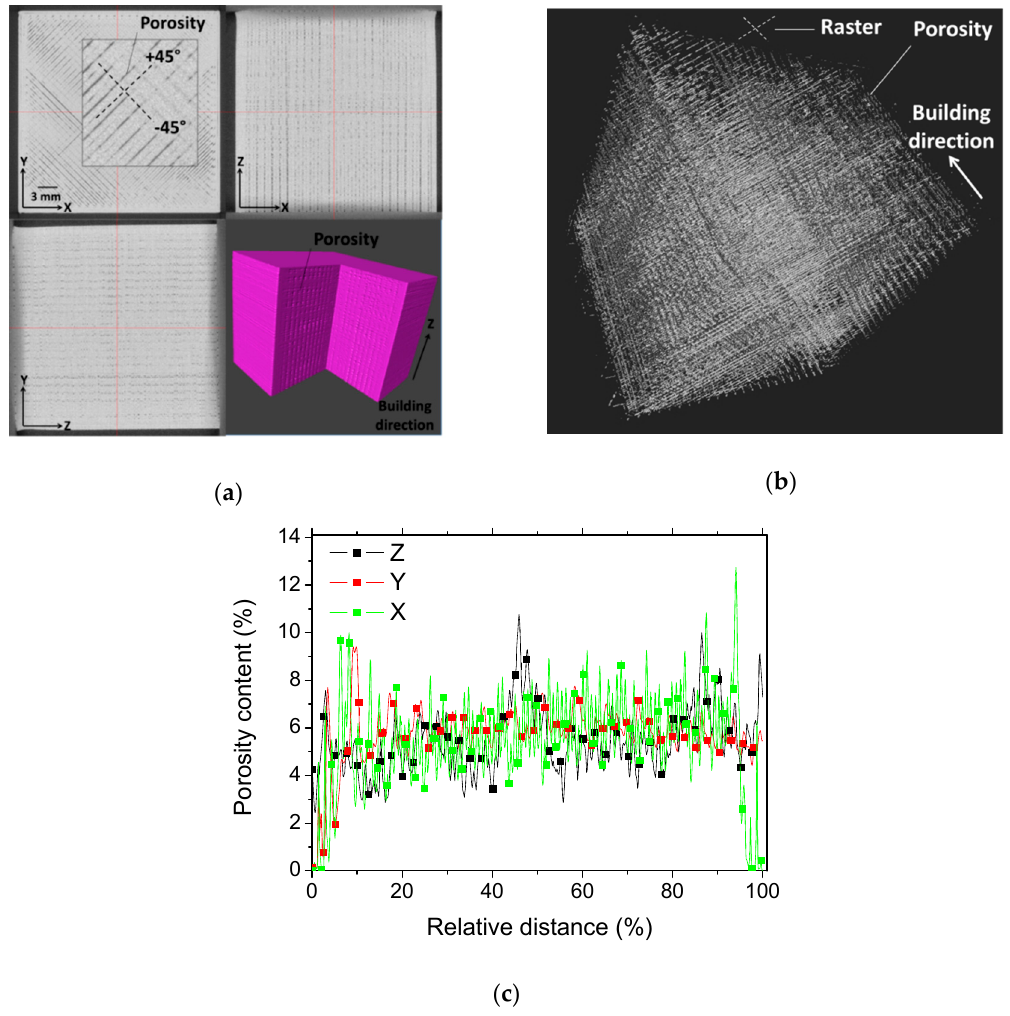
Figure 4. X-ray microtomography results ( a ) Cross-section and perspective views of 3D printed dense PLA imaged using X-ray micro-tomography, ( b ) porous network of 3D printed dense PLA and ( c ) related porosity content profiles in the main directions of the structure.